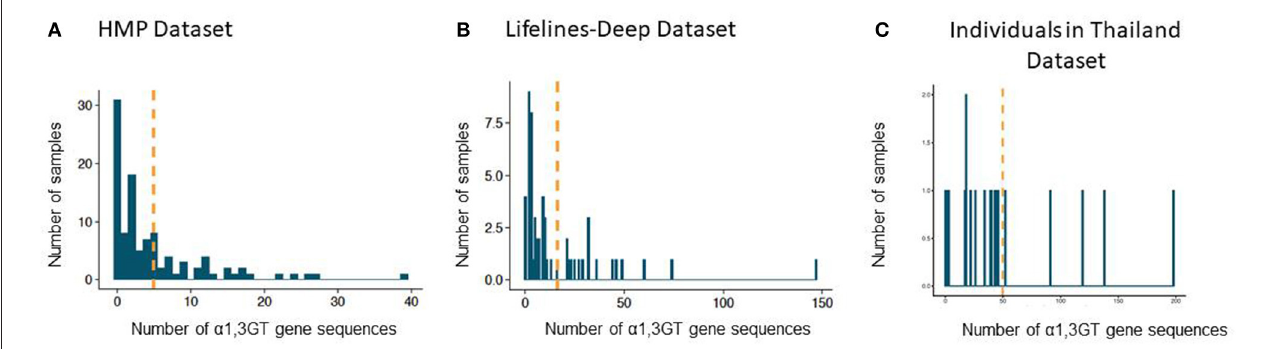
FIGURE 2 | Presence of sequences with α 1,3GT sequence homology in the gut microbiome of adult individuals from two cohorts. (A) Number of hits for α 1,3GT sequences in the HMP dataset (106 individuals), mean number = 5. (B) Number of hits for α 1,3GT sequences in DEEP lifelines dataset (57 individuals), mean number = 16. (C) Number of hits for α 1,3GT sequences in Asian American dataset (20 individuals), mean number = 50. BURST was used with sequence identity homology cutoff of 0.85. The orange line represents the mean number of α 1,3GT homologs present per patient.